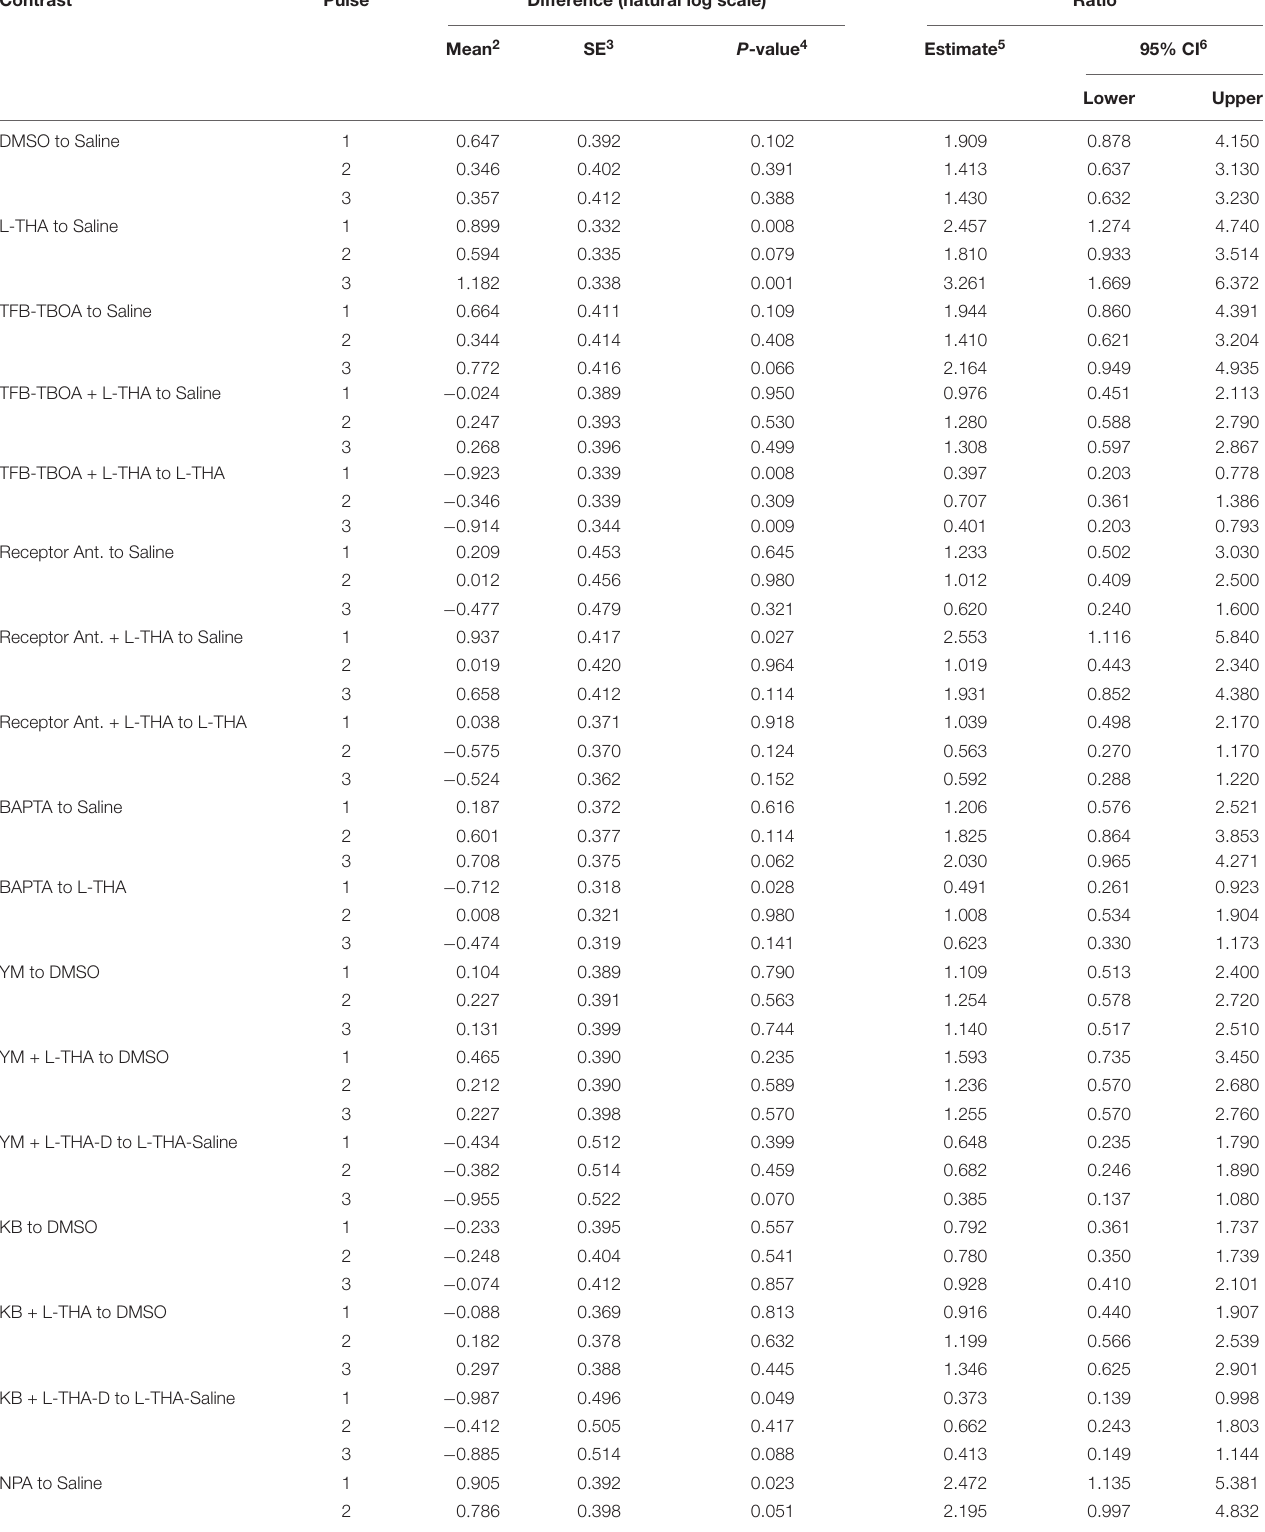
TABLE 4 | Individual pulses – Max change 1